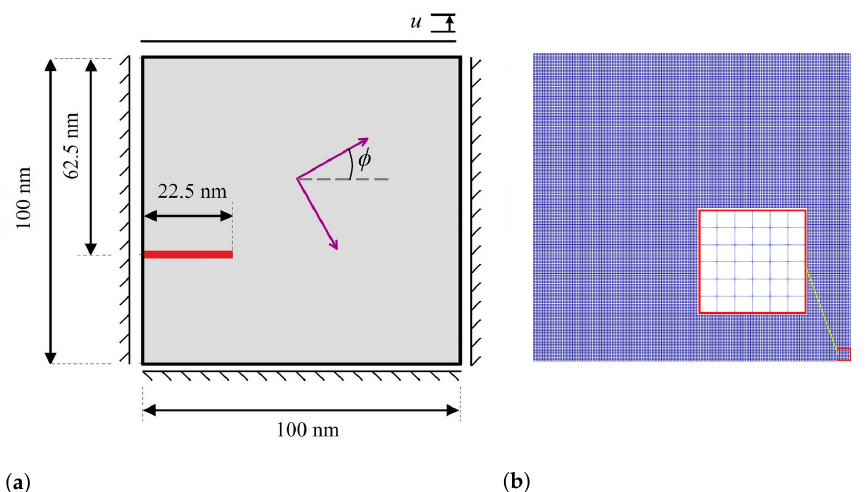
Figure 4. ( a ) Schematic representation of a specimen with initial crack under Mode I loading; ( b ) finite element mesh of the